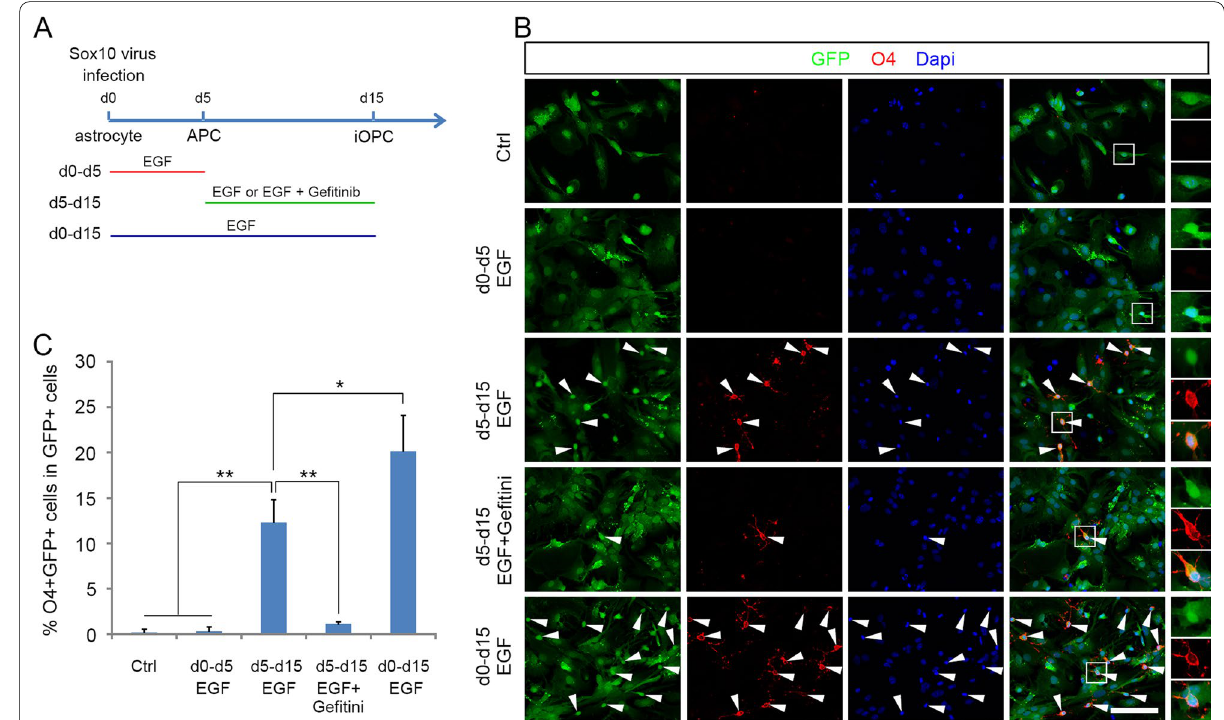
Fig. 3 EGF promotes the switch of APCs to iOPCs. A The schematic of EGF and Gefitinib treatments at different time points during Sox10-induced reprogramming. B After infection with Sox10-GFP virus, the cells were cultured in five different culture conditions for 15 days, then immunostaining was performed with O4 antibody. C Quantification of the percentage of O4 + cells in five separate reprogramming cultures. Statistical analyses are presented as Mean SD, n 3. *P < 0.05, **P < 0.01. Scale bars, 50 ± =